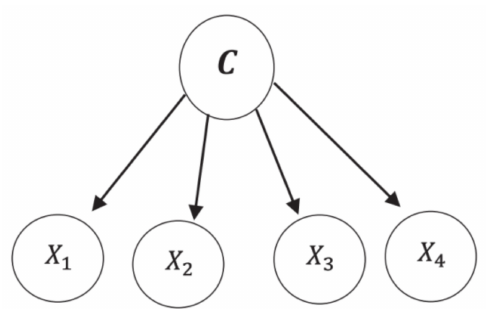
Figure 4. A typical Naive Bayes classifier diagram